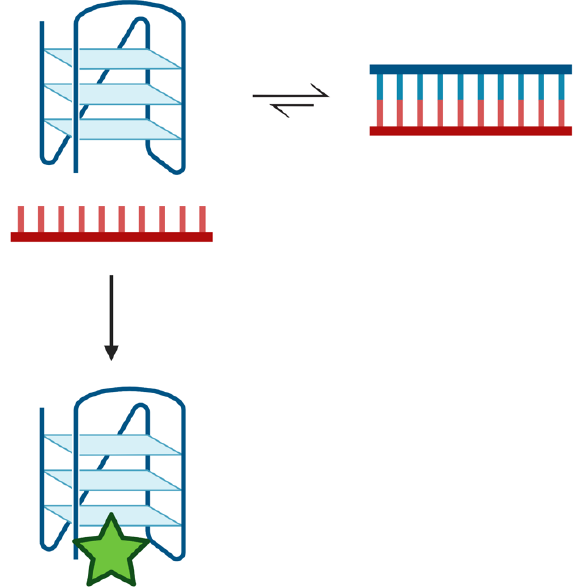
Figure 7. Duplex–quadruplex equilibrium scheme. Potentially quadruplex-forming regions of the genome are in equilibrium with duplex. Duplex is the preferred configuration in the presence of the complementary strand [22–24]. Transiently, a quadruplex may form that can be ‘trapped’ by quadruplex-binding ligands, such as pyridostatin (green star). The ligand stabilizes the quadruplex structure such that it prevents its unfolding and reforming duplex. Created with Biorender.com